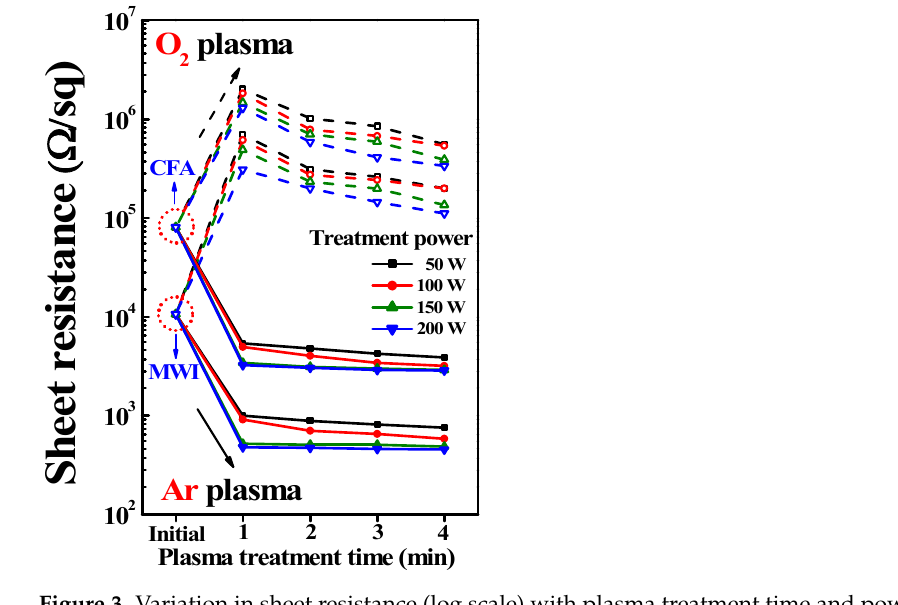
Figure 3. Variation in sheet resistance (log scale) with plasma treatment time and power for MWI and conventional furnace annealing (CFA) ITO films.